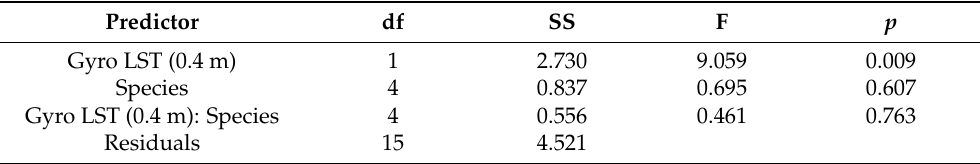
Table 3. ANOVA table for the regression model testing gyrocopter LST at 0.4 m resolution and tree species identity, and their interaction, to predict air temperatures at the tree crown level; df = degrees of freedom, SS = sum of squares, F = F-value, p = p -value. Predictor df SS F Gyro LST (0.4 m)